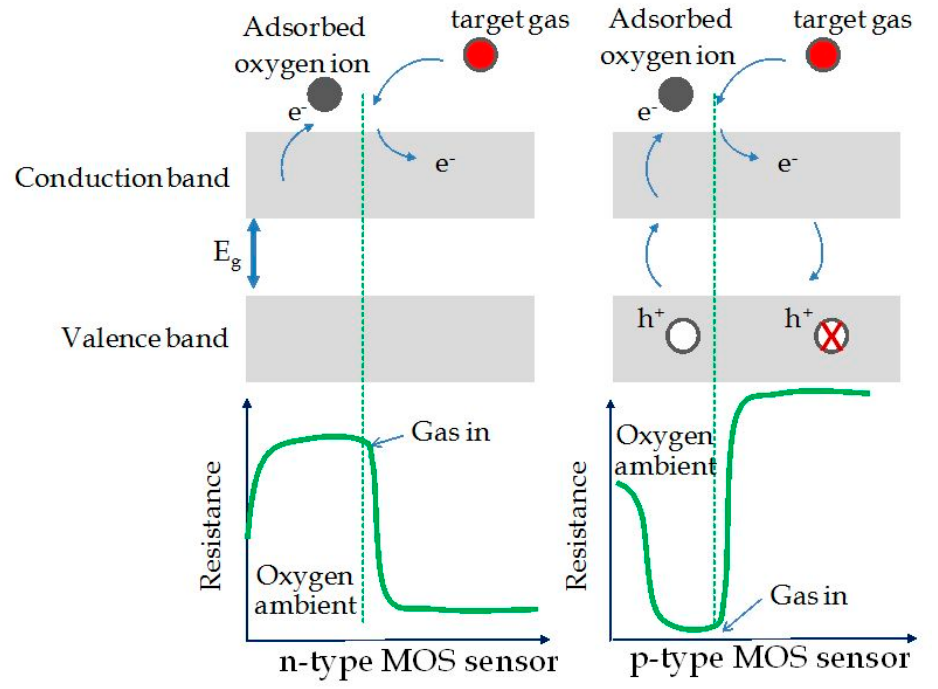
Figure 4. Schematic diagram for change of the sensor resistance upon exposure to the target gas (reducing gas) in the cases of n-type and p-type metal oxide sensors. Reprinted under the terms of the Creative Commons Attribution License (CC BY 3.0) from Ref. [54].